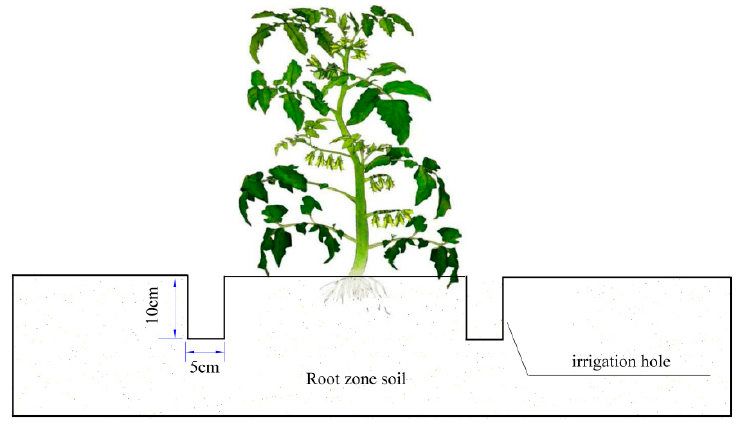
Figure 2. Schematic diagram of irrigation holes.